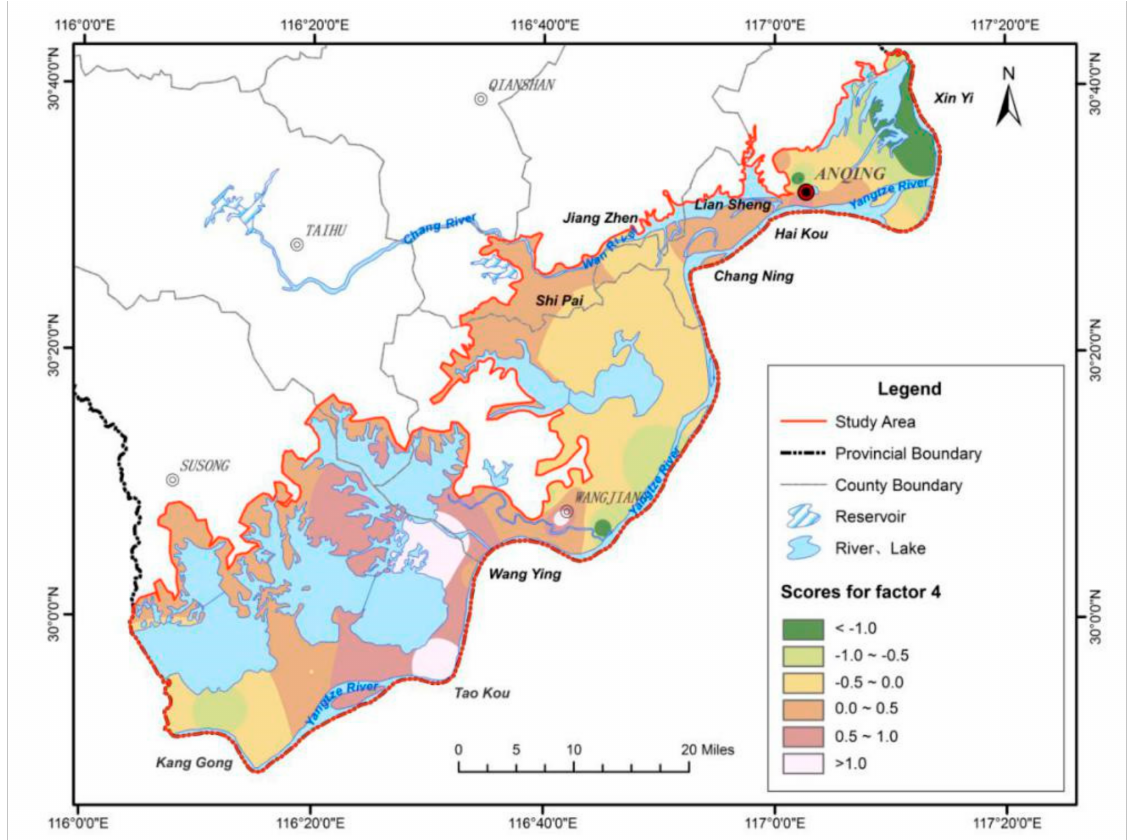
Figure 9. Distribution of scores of factor 4 for phreatic